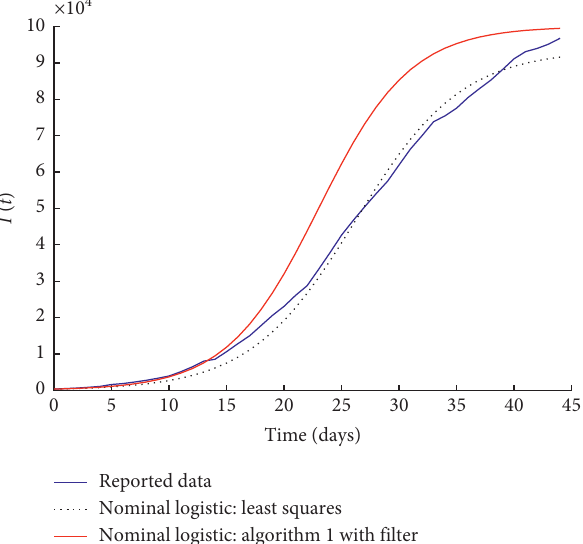
Figure 21: Comparison of reported data with the output of the estimated nominal logistic